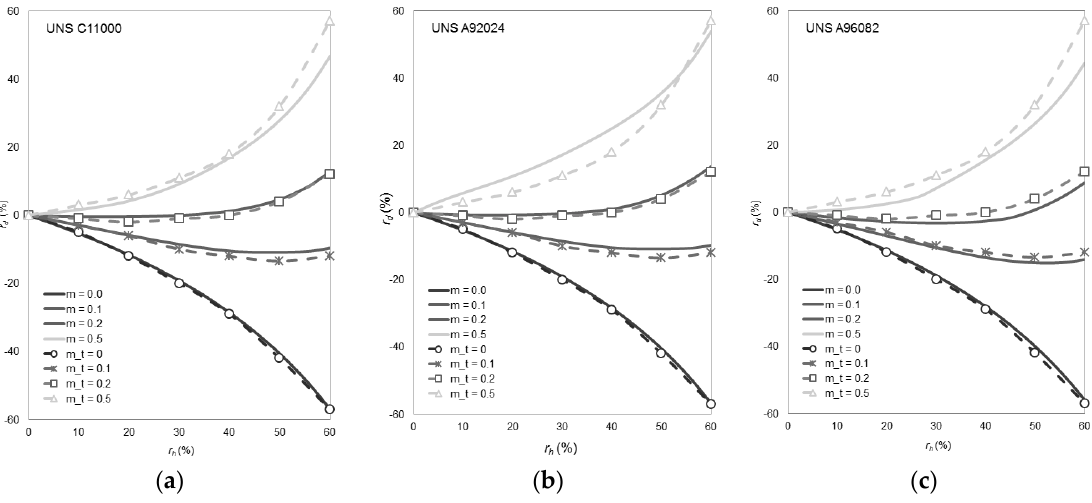
Figure 8. Finite element model validation with theoretical results obtained by De Pierre et al. [29].